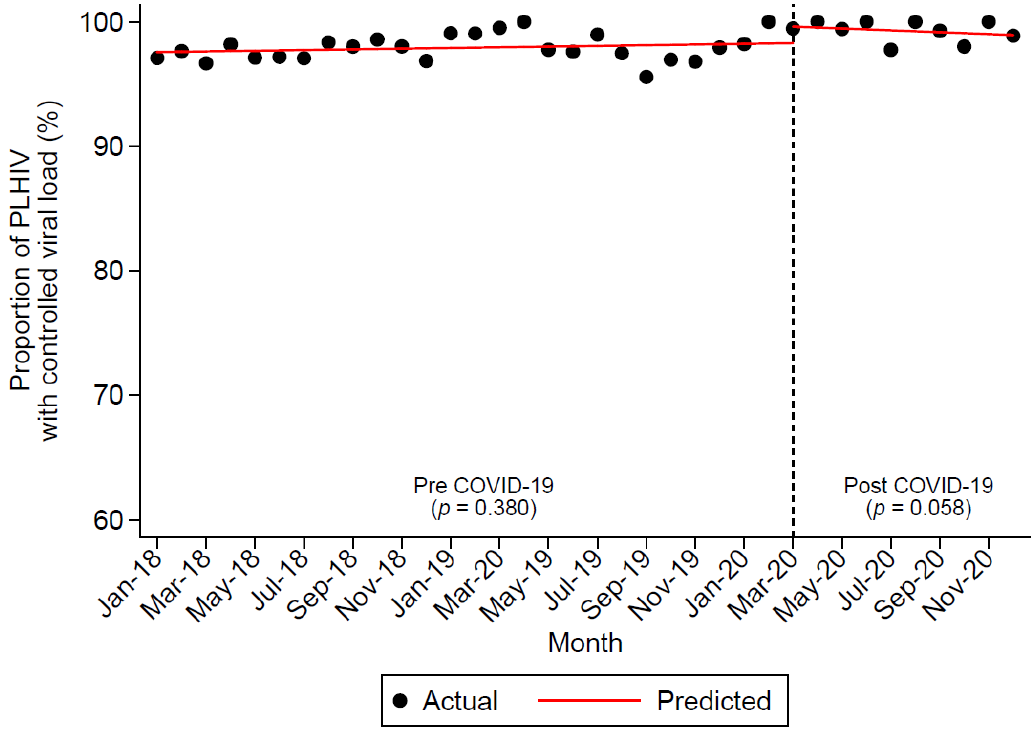
Figure 2. Segmented linear regression analysis of the percentage of undetectable viral load before and during the COVID-19 pandemic (indicated by the dotted line).